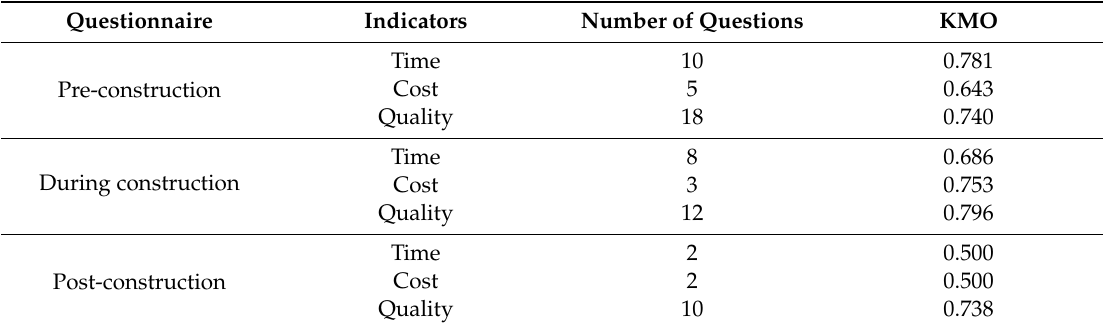
Table 1. Distribution of questions in the questionnaire and the Kaiser-Meyer-Olkin test